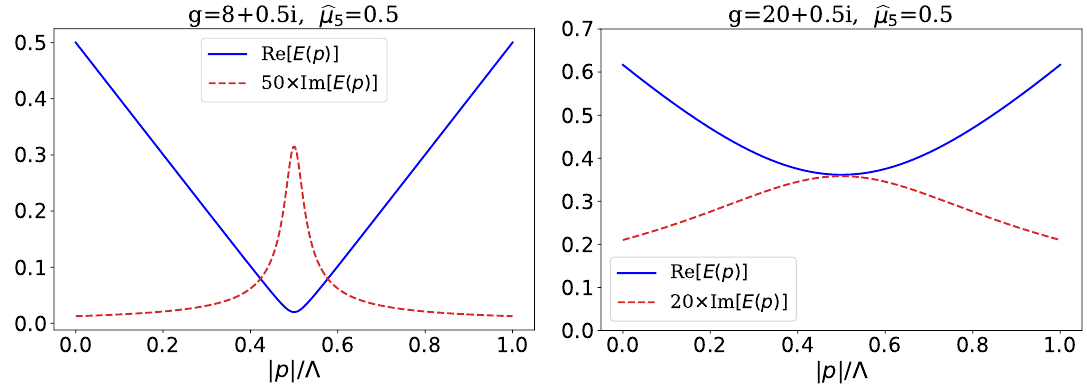
Figure 6. The complex energy spectra of quasiparticles for weak (left) and strong (right) coupling.